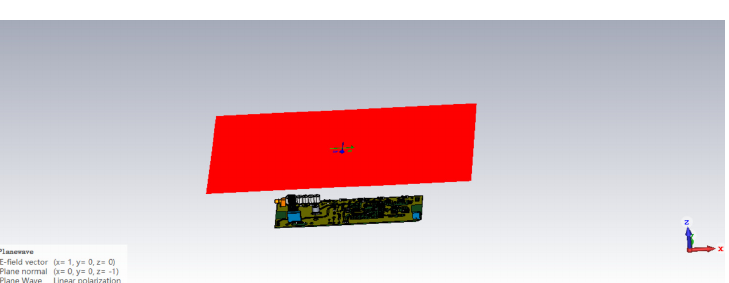
Figure 2. The applied Gaussian pulse signal.